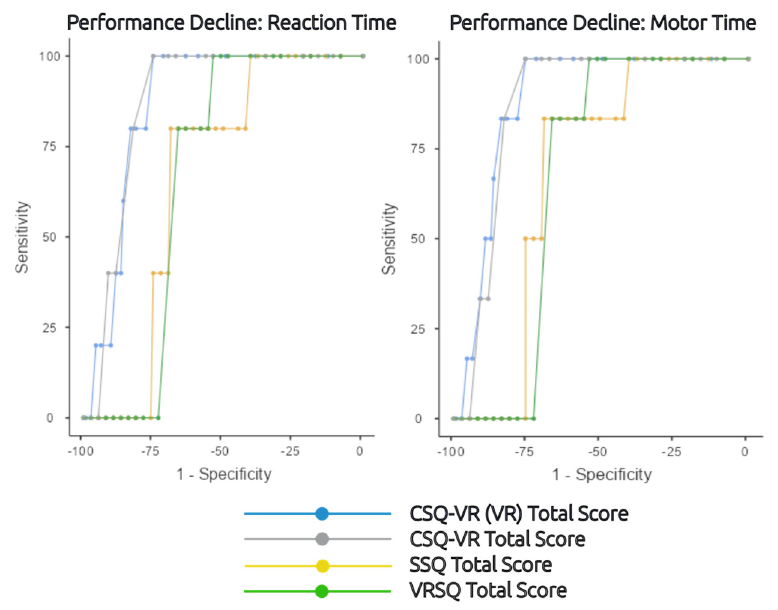
Figure 6. Sensitivity and Specificity of the CSQ-VR, SSQ, and VRSQ Total Scores in detecting Reaction Time ( Left ) and Motor Speed ( Right ) Decline. Note: (VR) = VR version. Table 7. Psychometric Properties of the CSQ-VR, SSQ, and VRSQ Vestibular/Disorientation Scores in detecting Reaction Speed Decline.